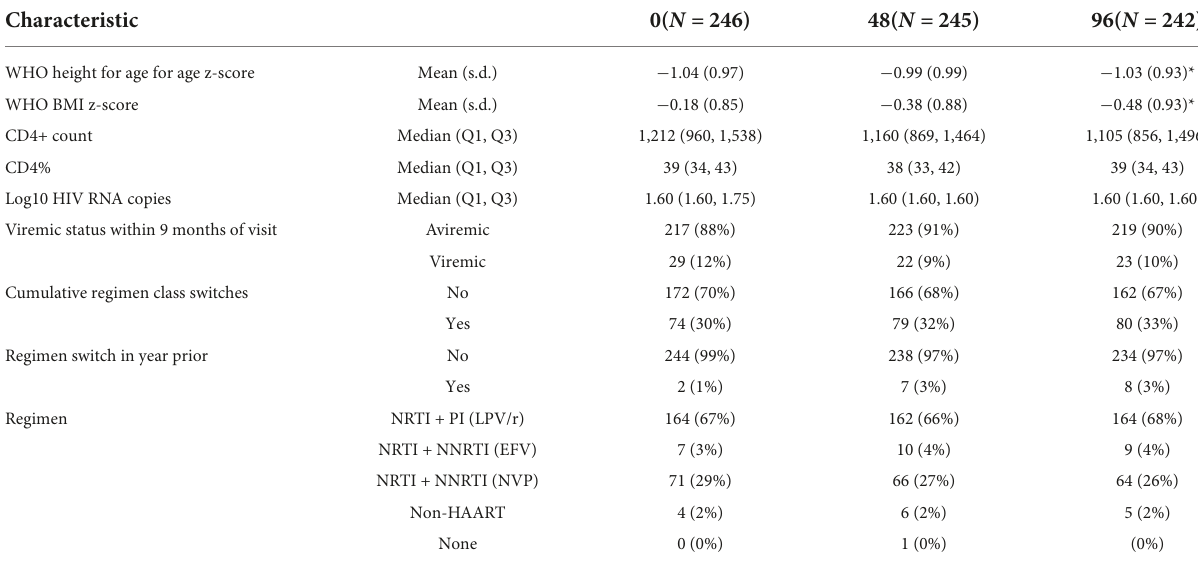
TABLE 2 Clinical, immunological and virologic progress on the P1104S